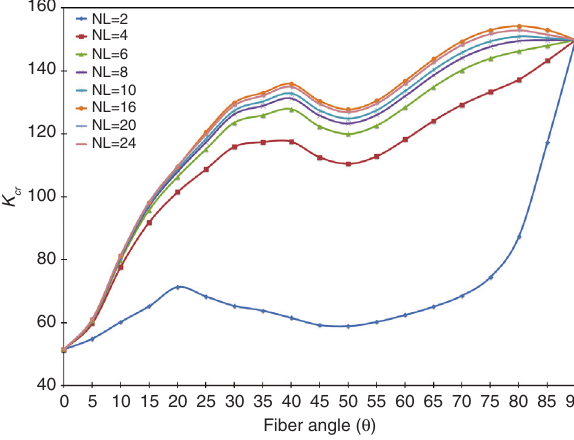
Figure 14 Critical buckling load parameter for clamped antisym- metric cylindrical skew panel (Ø = 15 ° , α = 45 °